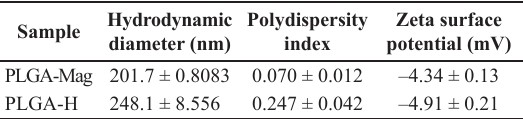
Table 1. Hydrodynamic diameter, polydispersity and zeta surface potential of PLGA-Mag and PLGA-H samples. Sample